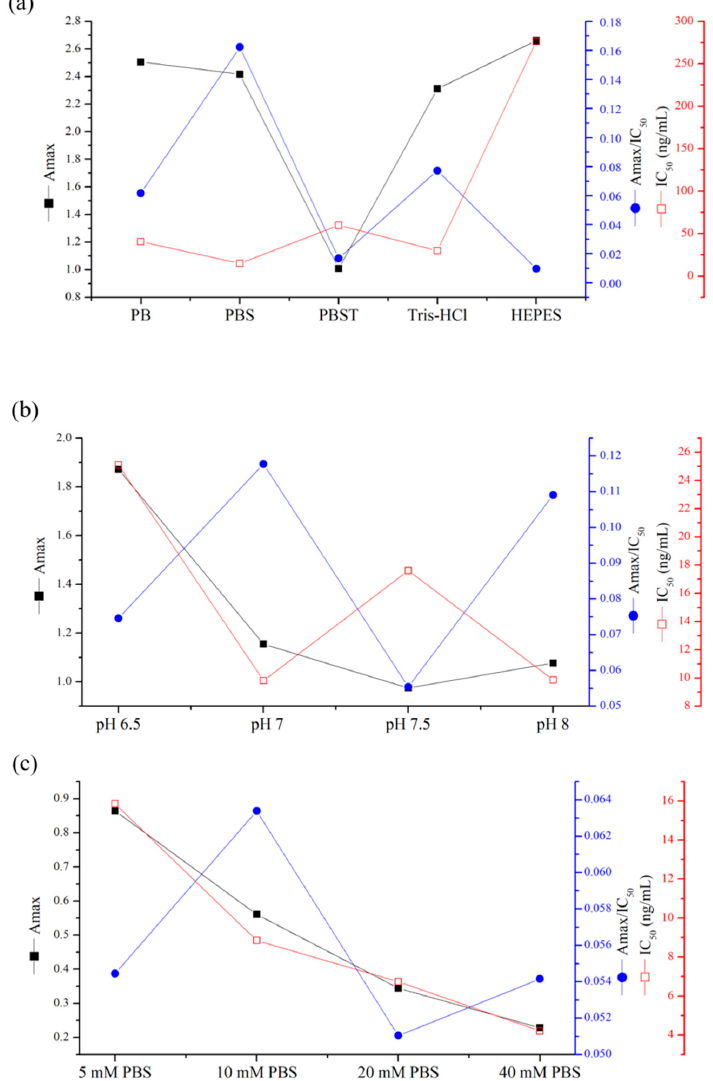
Figure 6. Optimization of assay conditions for the establishment of ic-ELISA: ( a ) types of buffers (PB, PBS, PBST, Tris-HCl, and HEPES), ( b ) pH value (6.5, 7.0, 7.5, and 8.0), and ( c ) ionic strength (5 mM, 10 mM, 20 mM, and 40 mM PBS). The conditions were evaluated by the Amax (maximal absorbance)/IC 50 ratio.